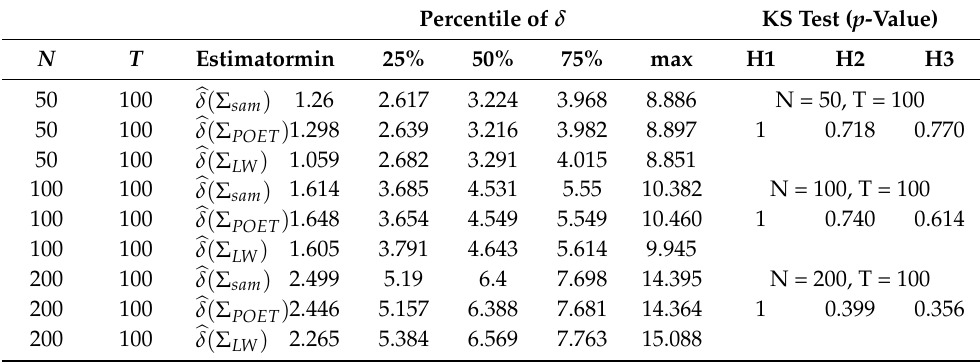
Percentile of δ KS Test ( p -Value)